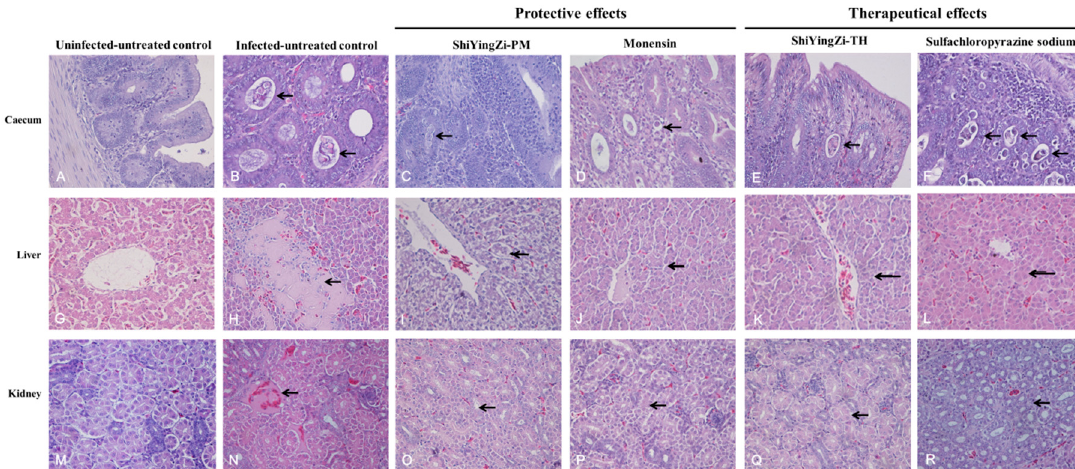
Figure 1. Histopathological examination (400 × ). In the cecum ( A – F ), oocysts invaded the cecum mucosa and intestinal gland (( B ), denoted by an arrowhead) and serious karyopyknosis and necrocytosis were detected in cecum mucosa cells; in the ShiYingZi-PM group ( C ), ShiYingZi-TH group ( E ), and positive control groups (( D ), monensin; ( F ), sulfachloropyrazine sodium), few oocysts were observed in cecum mucosa cells (denoted by an arrowhead), and the cecum mucosa cells were granular and exhibited vacuolar degeneration; ( A ) the uninfected-untreated group. In the liver ( G – L ), Eimeria tenella infection induced serious hepatocyte necrosis and inflammatory cell infiltration (( H ), denoted by arrowhead); granular and vacuolar degeneration (denoted by arrowhead) appeared in the ShiYingZi-PM group ( I ), positive control group (( J ), monensin; ( L ), sulfachloropyrazine sodium), and ShiYingZi-TH group ( K ); ( G ) the normal structure of the liver. In the kidney ( M – R ), serious granular and vacuolar degeneration and cell necrosis were observed in the infected-untreated group (( N ), denoted by arrowhead); little granular and vacuolar degeneration (denoted by an arrowhead) was observed in the ShiYingZi-PM group ( O ), ShiYingZi-TH group ( Q ), and positive control group (( P ), monensin; ( R ), sulfachloropyrazine sodium); in terms of the therapeutic e ff ects, more inflammatory cell infiltration was observed in the positive control group ( R ) than in the ShiYingZi-TH group ( Q ); ( M ) the uninfected-untreated